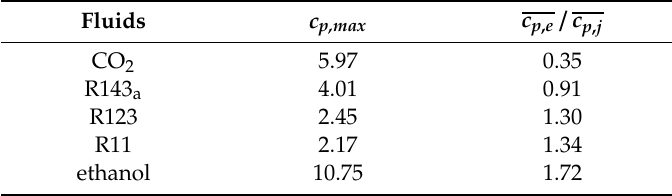
Table 8. Comparison of c p,max and c p , e / c p , j with di ff erent